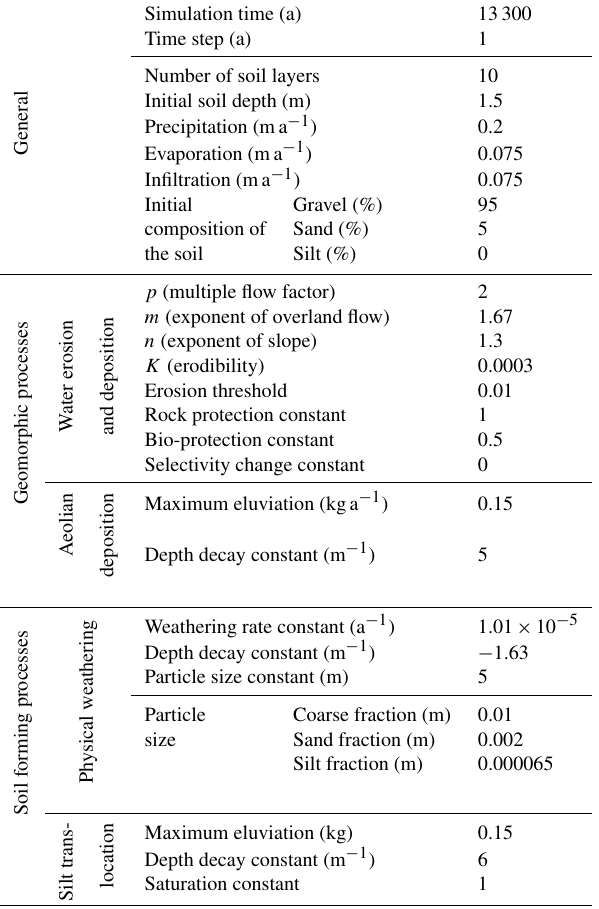
Table 1. Settings and parameters used as input for the LORICA